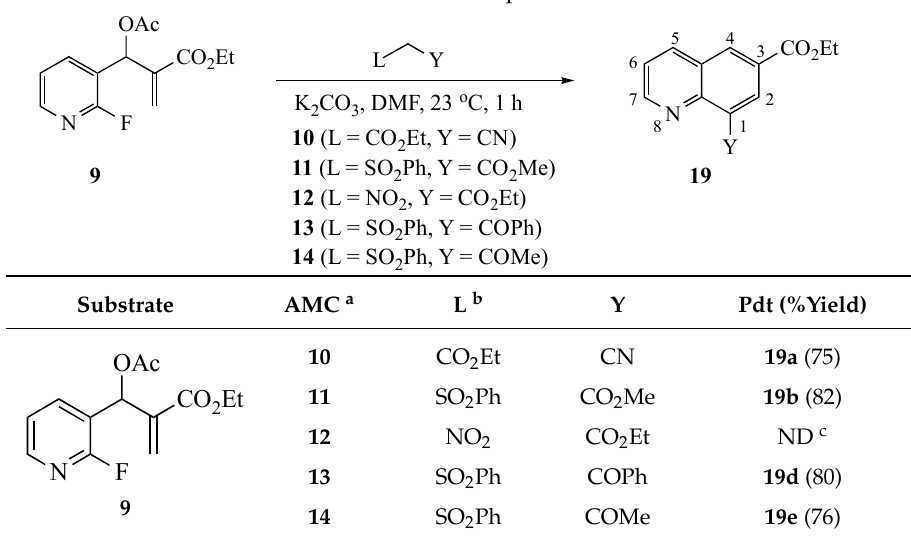
Table 2. Formation of quinolines.